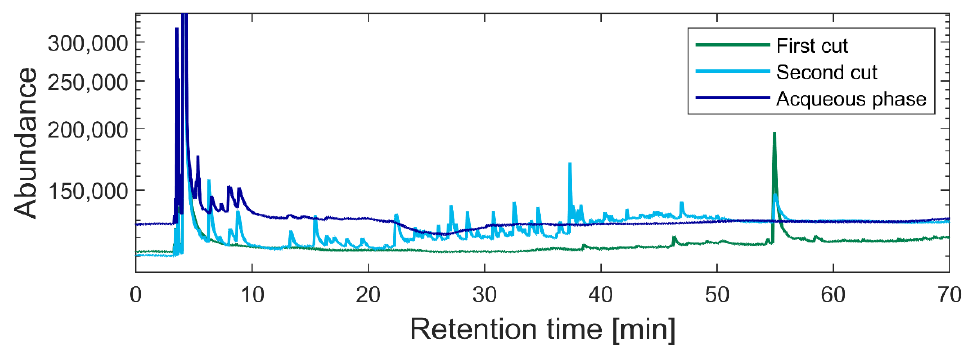
Figure 5. Overlaying spectra of the bio-oil samples produced via fractional condensation (FC_SC2).